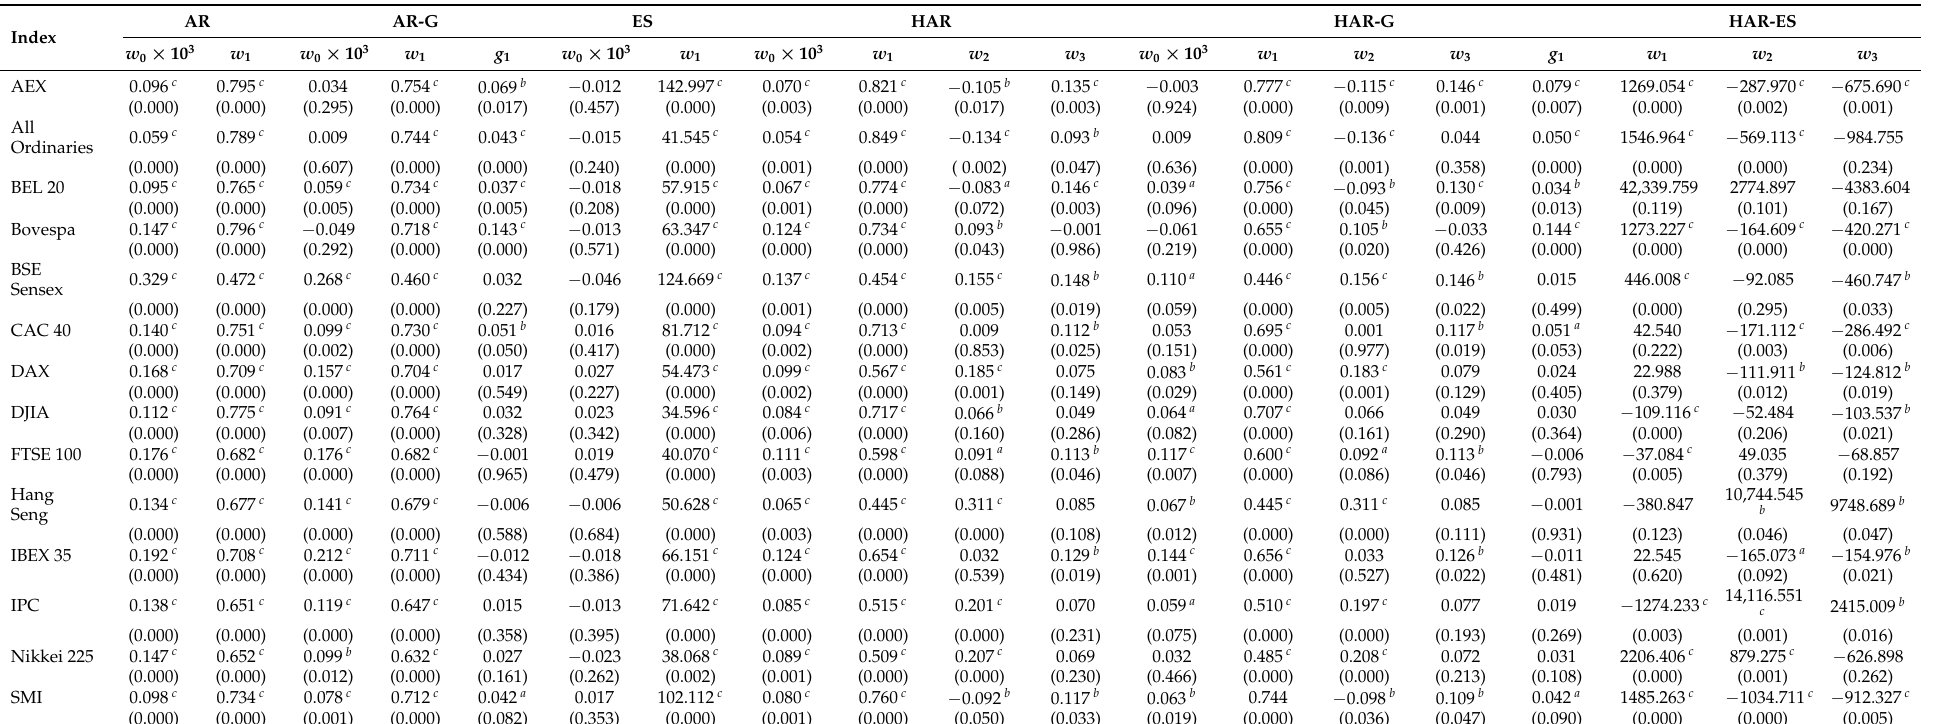
Table 5. In-sample results of predictive